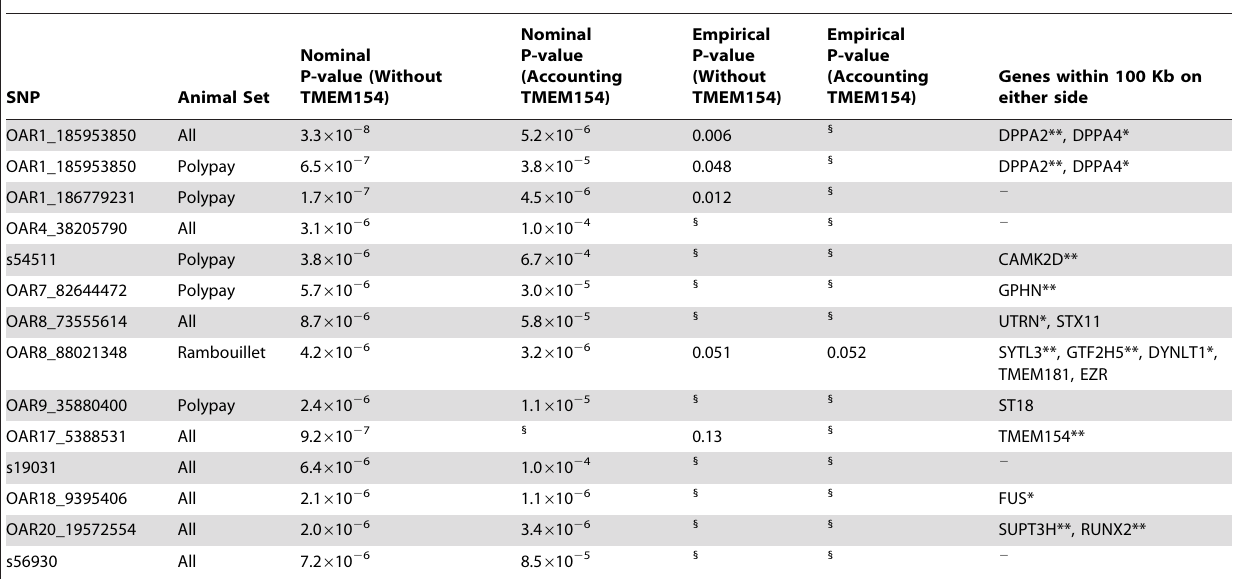
Table 2. Genomic regions associated with OvLV serologic status comparing association with and without accounting for TMEM154